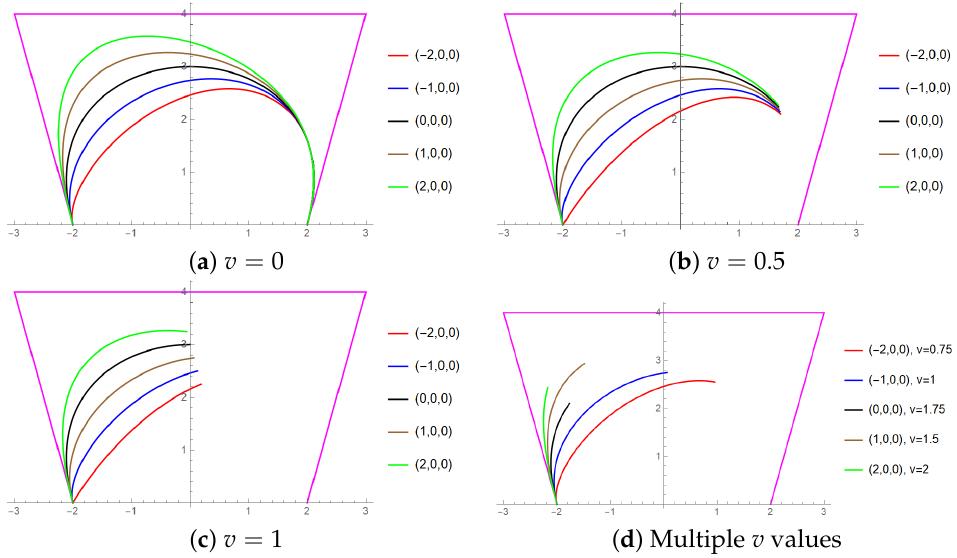
Figure 3. Cubic fractional Bézier curve with multiple values of v and a 1 shape